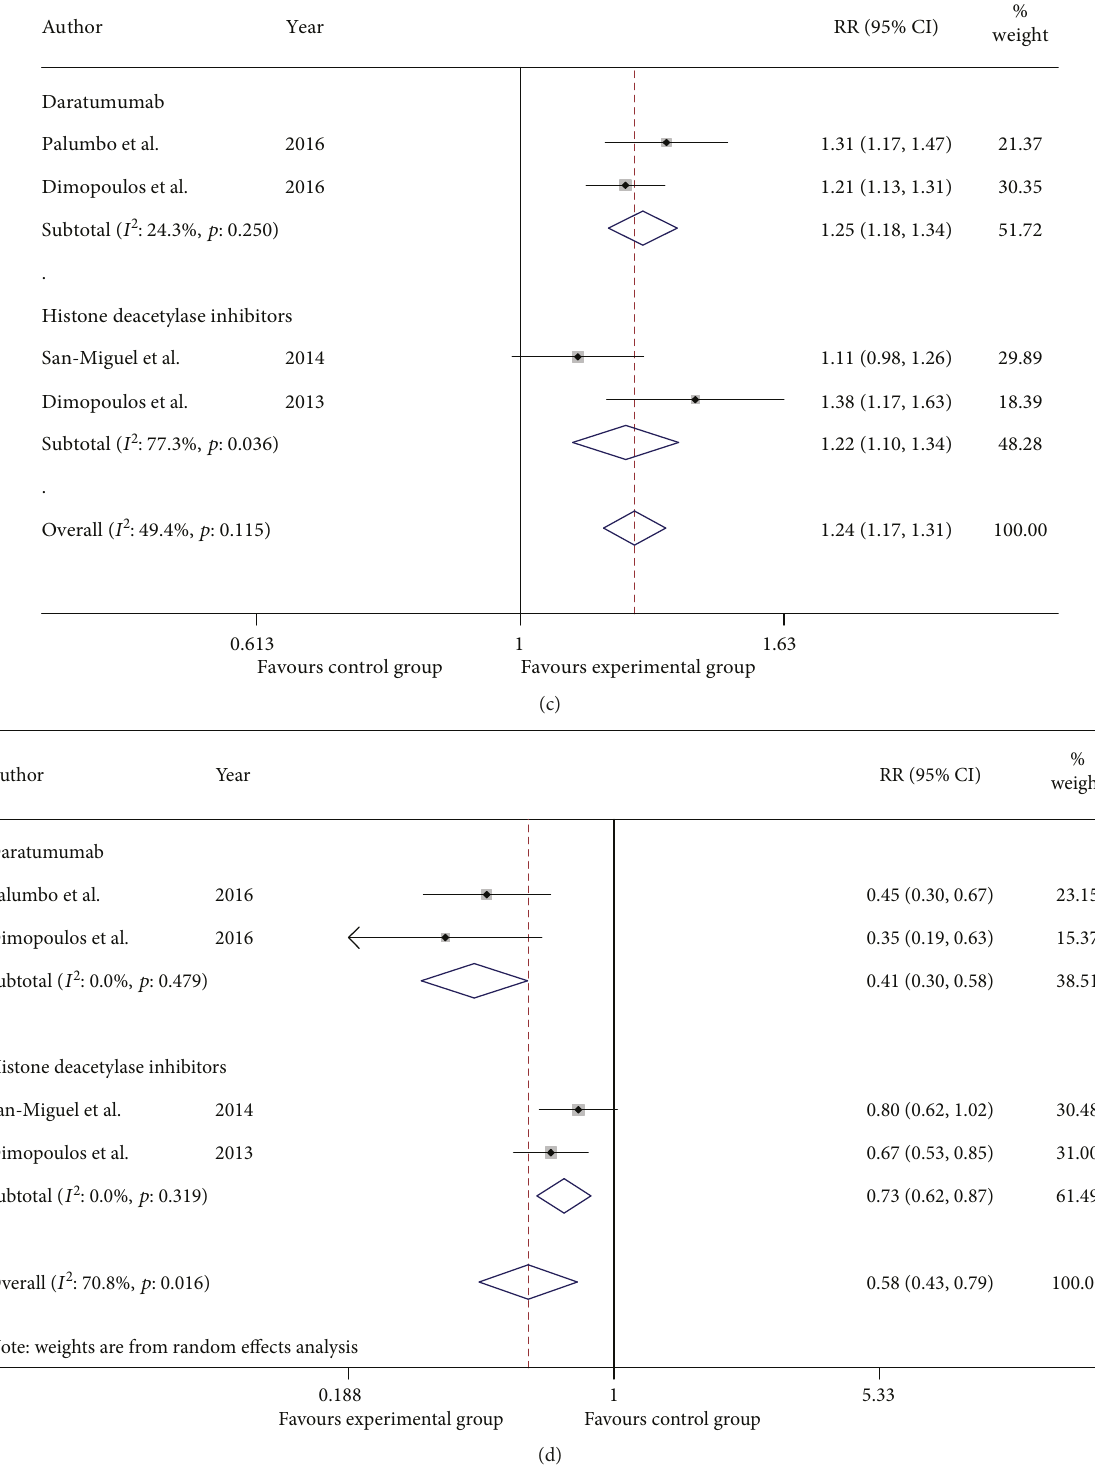
Figure 4: Meta-analysis of the e ffi cacy of daratumumab group and HDACi group in patients with RRMM: risk ratio for complete response (a), very good partial response (b), overall response (c), and progressive disease plus stable disease (d) of daratumumab group and HDACi group versus their corresponding control